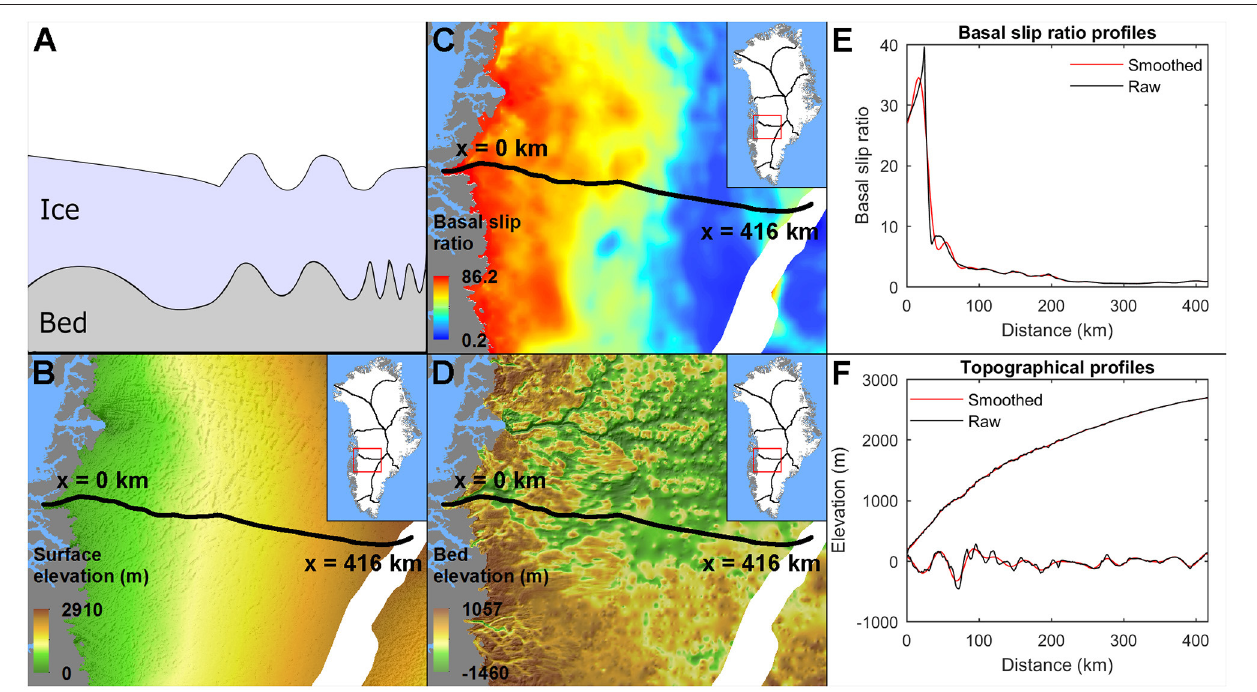
FIGURE 1 | (A) Cartoon illustrating the transfer of basal topographical variability (perturbations) to the ice surface. Ice flow behaves as a filter preferentially transferring bed topographical undulations of particular wavelengths compared to the ice thickness. (B) Maps of ice surface topography, (C) basal slip ratio (D) and bed topography in SW Greenland, showing a sample flowline (bold curve). (E) Raw profiles of basal slip ratio, (F) bed and surface elevations derived from the map along the flowline, and their corresponding smoothed versions. Areas around the ice divides are masked out to minimize edge